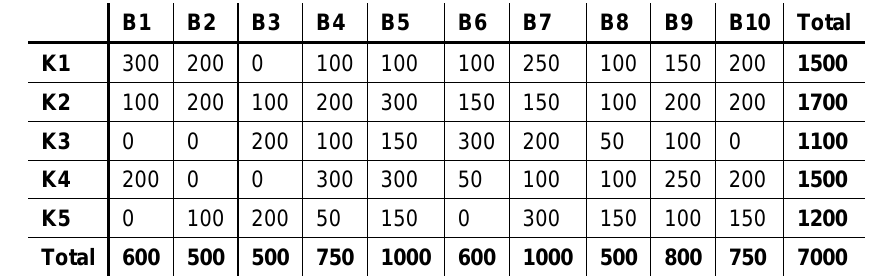
Table 1 – Overview of the user requests for the same type of